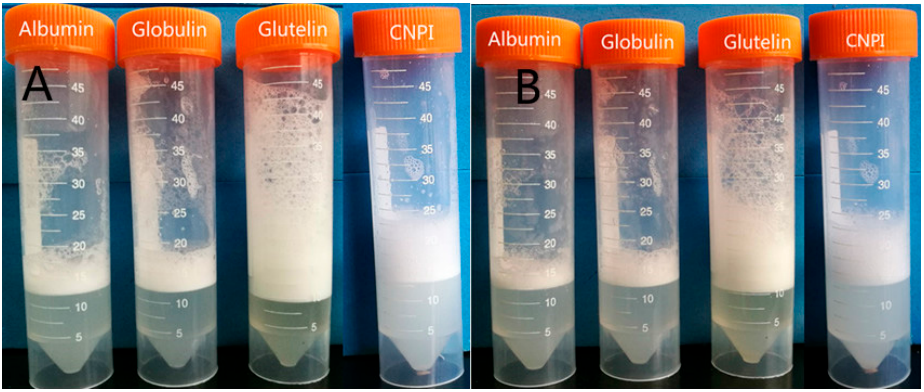
Figure 5. Foaming property of cashew nut albumin, globulin, glutelin and CNPI. The photograph of foaming volume after 0 min ( A ) and 30 min ( B ). foaming volume after 0 min ( A ) and 30 min ( B